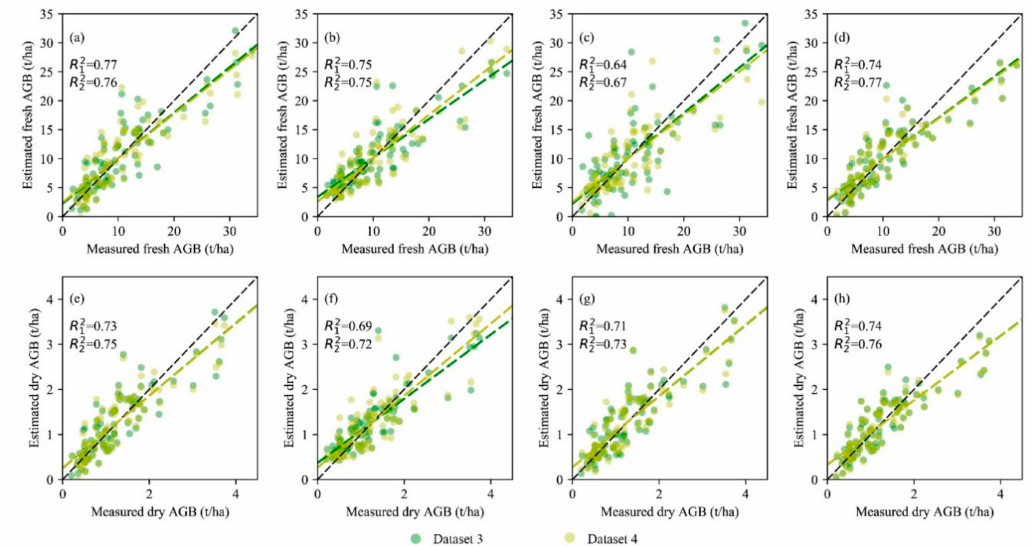
Figure 9. Comparisons of measured AGB and estimated AGB of maize via the four methods based on Dataset 3 (green spots) and Dataset 4 (yellow spots), which were derived from the Micasense RedEdge-M SfM point clouds: ( a – d ) OLS, RF, BP, and SVM for the AGB estimation of fresh maize; ( e – h ) OLS, RF, BP, and SVM for the AGB estimation of dry maize. R 12 and R 22 represent the coe ffi cient